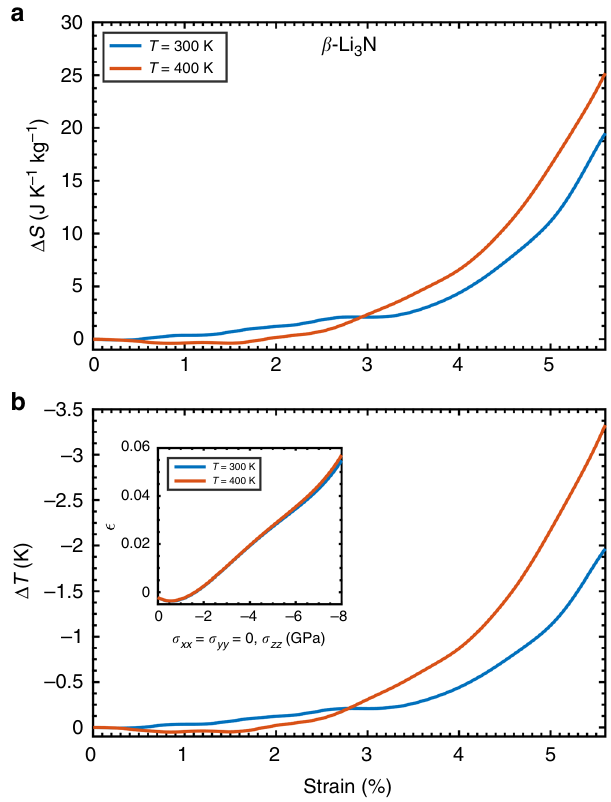
Fig. 5 Inverse elastocaloric effects in β -Li 3 N. a Isothermal entropy and b adiabatic temperature shift results. The relationship between uniaxial tensile stress and strain deformation along the Cartesian z direction, or equivalently the hexagonal c -axis, is shown in the inset